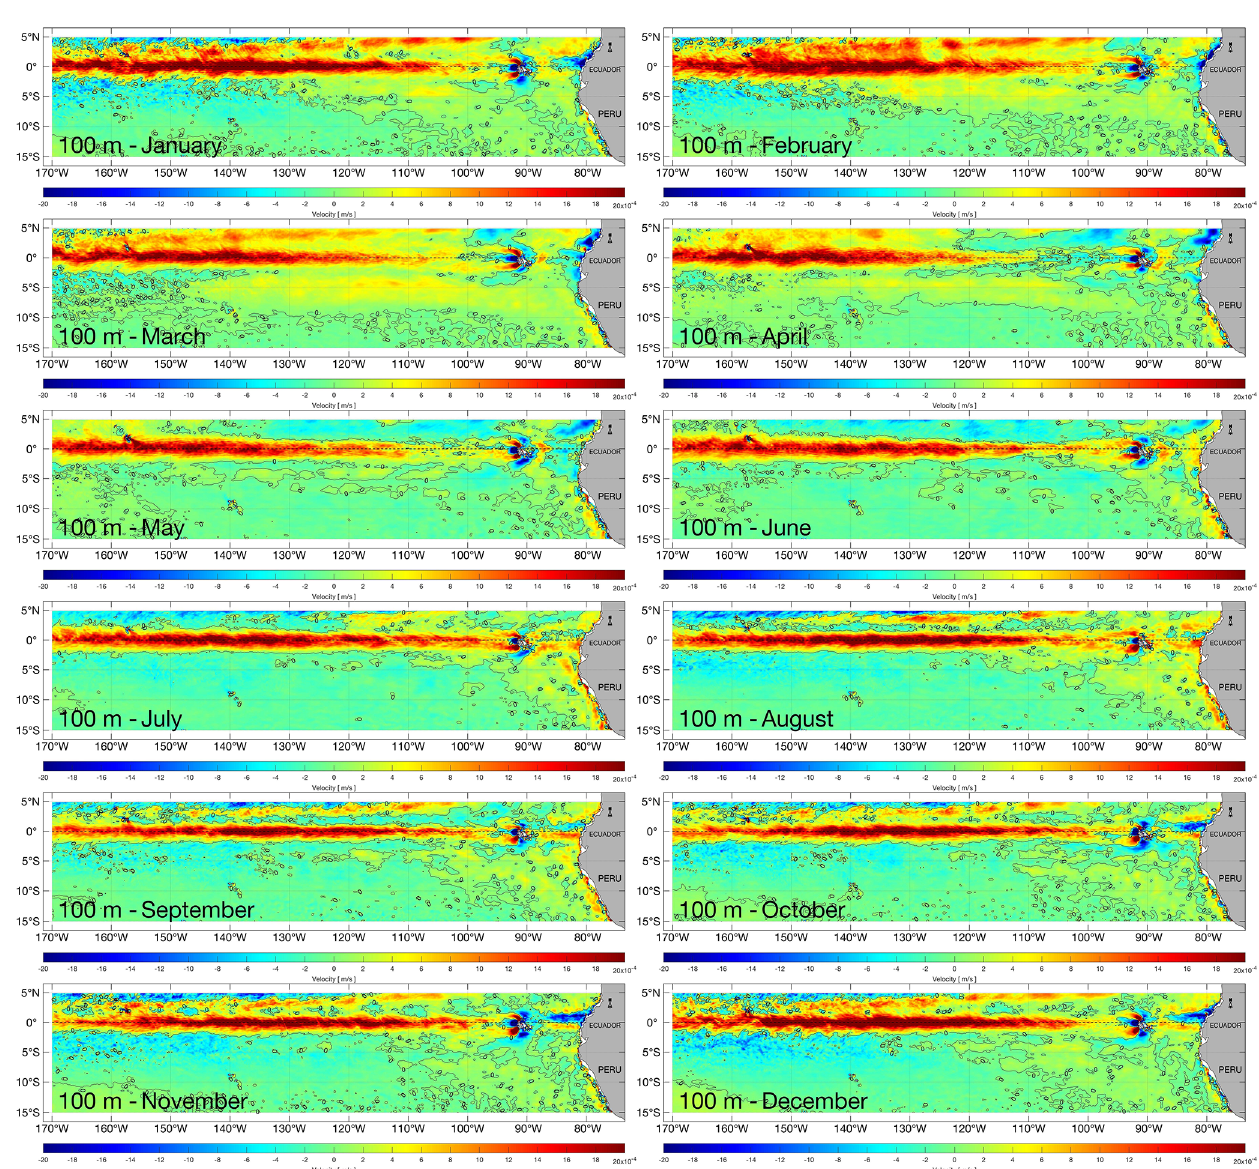
Figure 4. Monthly climatologies (averaged over 1988–2007) of vertical velocity at a depth of 100m in the eastern Pacific from the NEMO- ORCA12